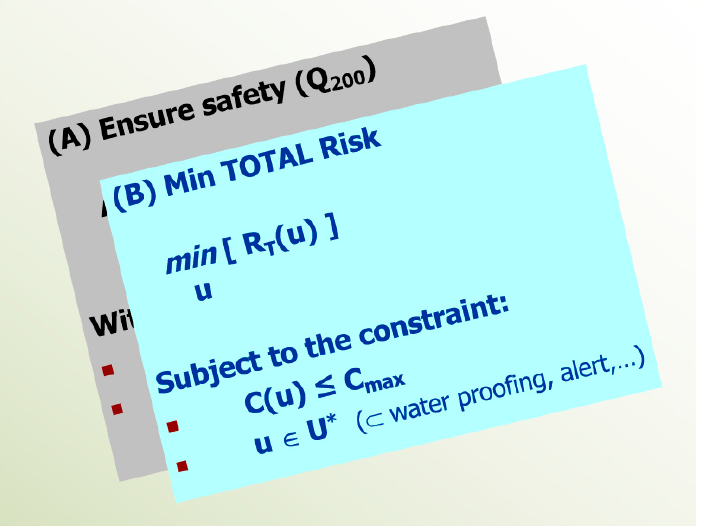
Figure 3. An evolved paradigm centered on the total risk R T including the residual risk (R R ), and a broader spectrum U * of possible interventions, under a maximum expenditure constraint C max .